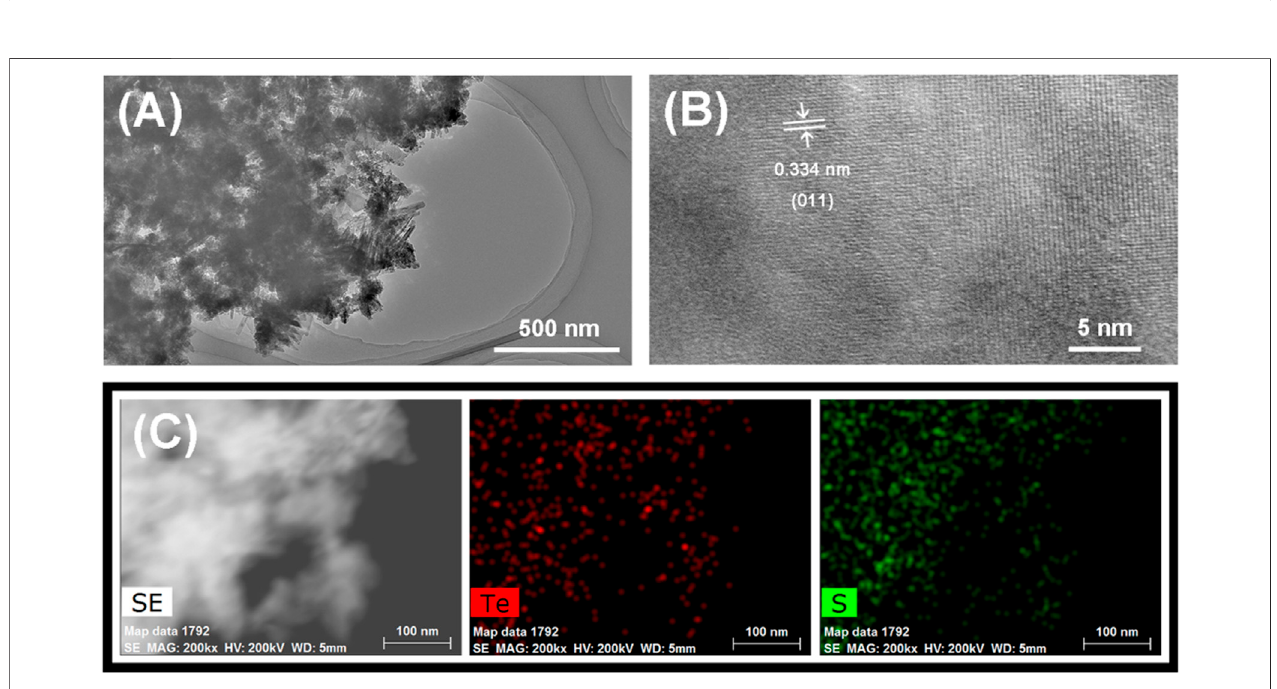
FIGURE 2 | Characterization of Te x S y : (A) TEM, (B) HRTEM, (C) EDS.